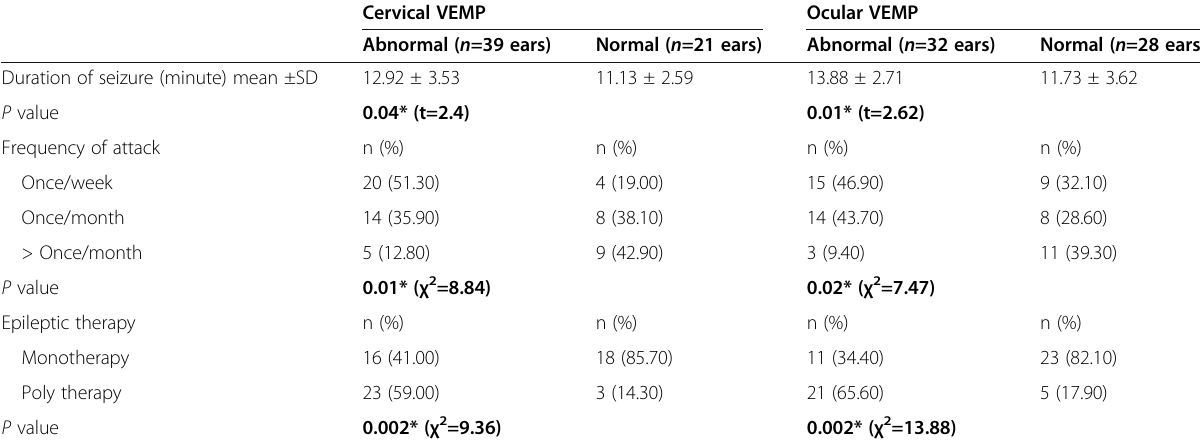
Table 3 Relationship between abnormal VEMP and duration of seizure, frequency of attacks, and type of therapy among the epileptic